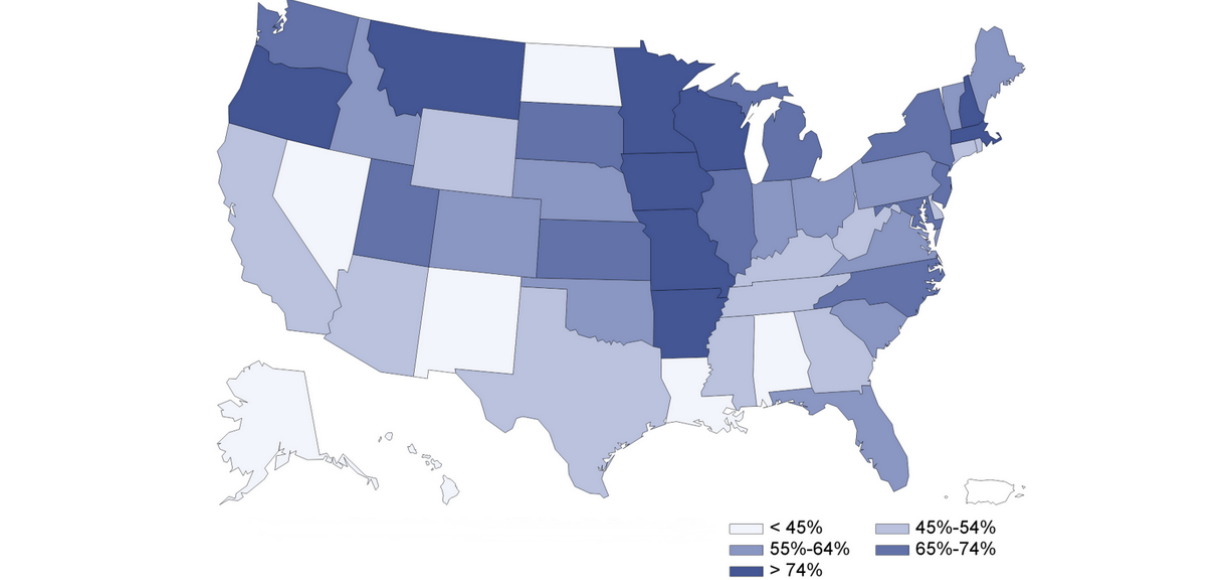
Figure 3. Proportion of hospitals that adopted the telehealth system by US state. RSV: relative search volume.